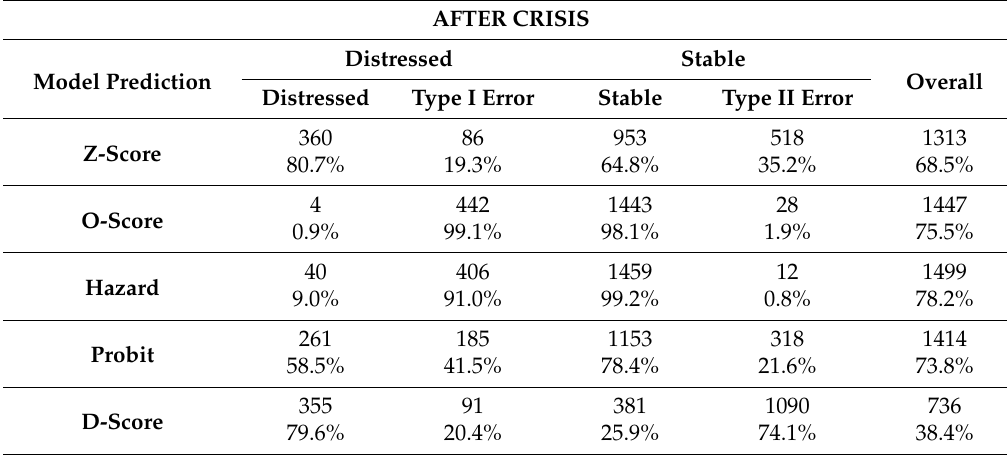
Table 8. Prediction accuracy of models after financial